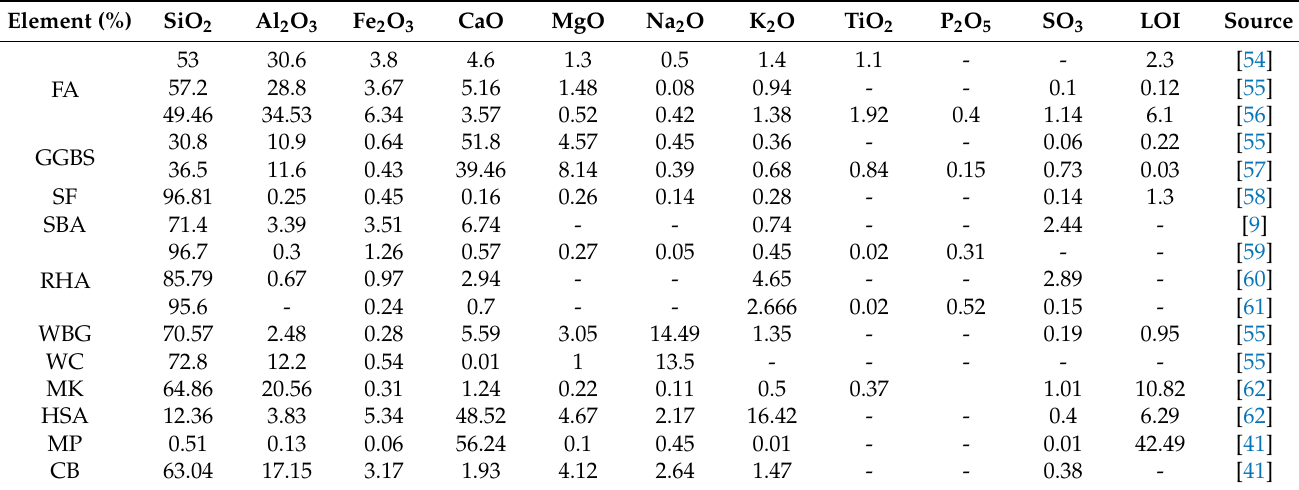
Table 2. Chemical composition of